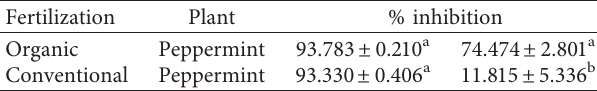
Table 4: Radical scavenging activity of peppermint as a result of type of fertilization a